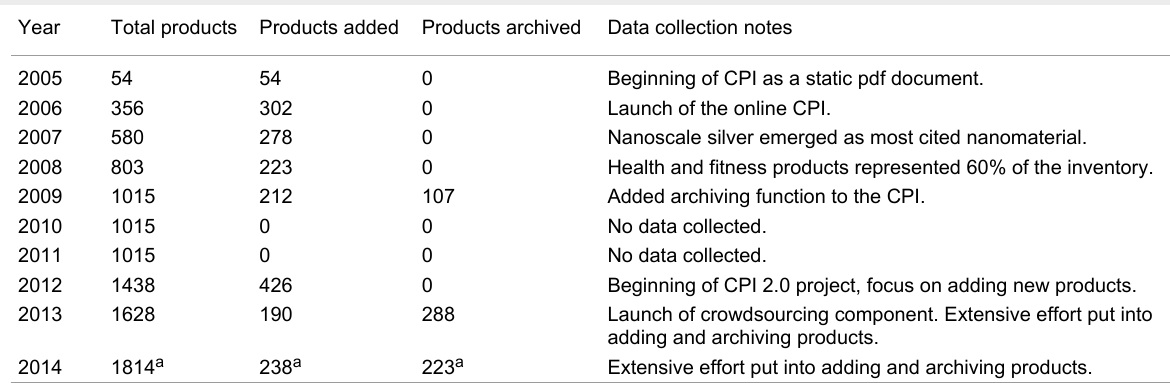
Table 1: Number of products in the CPI over